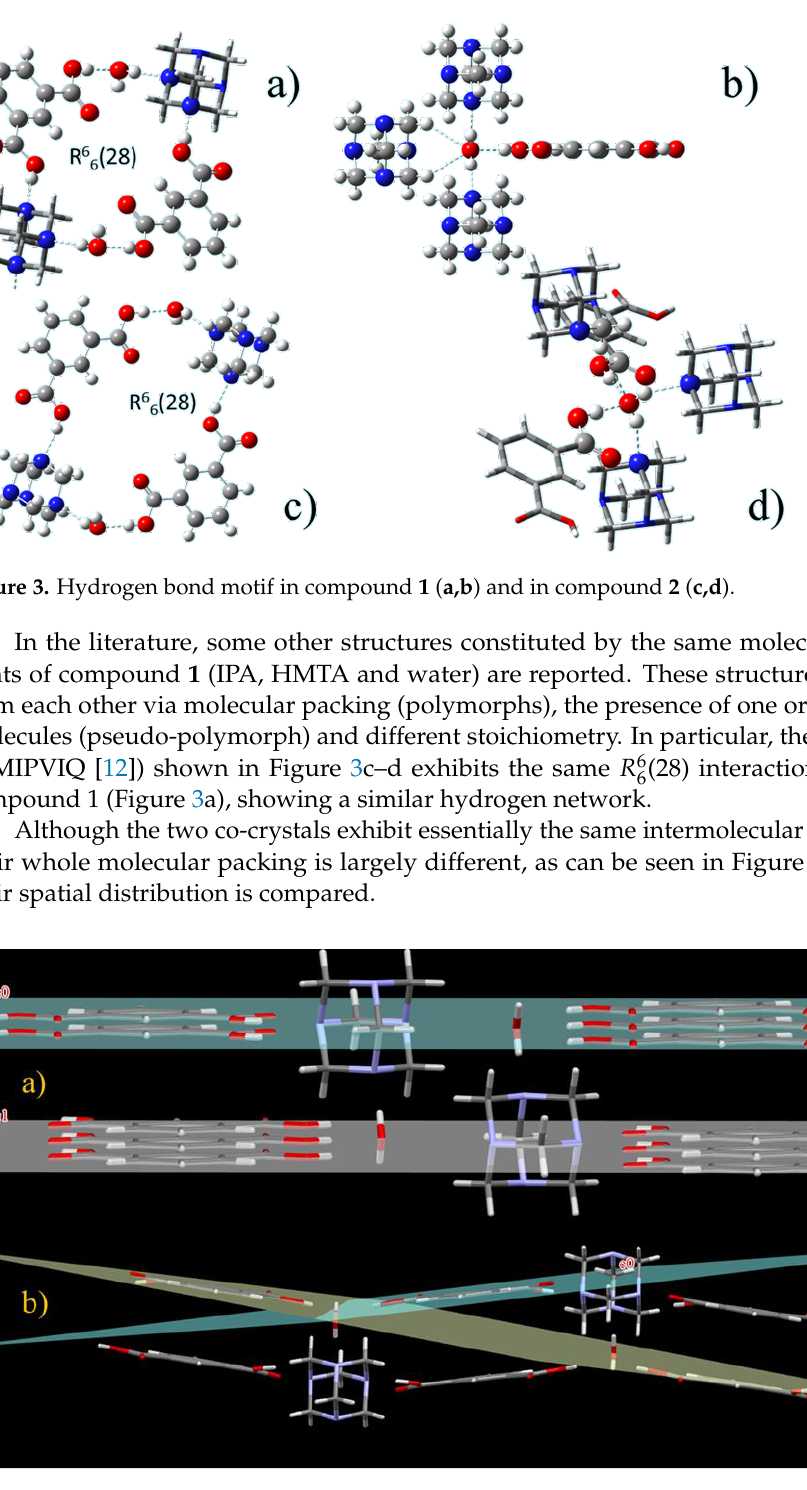
Figure 4 . General packing in compound 1 ( a ) and in compound 2 ( b ).